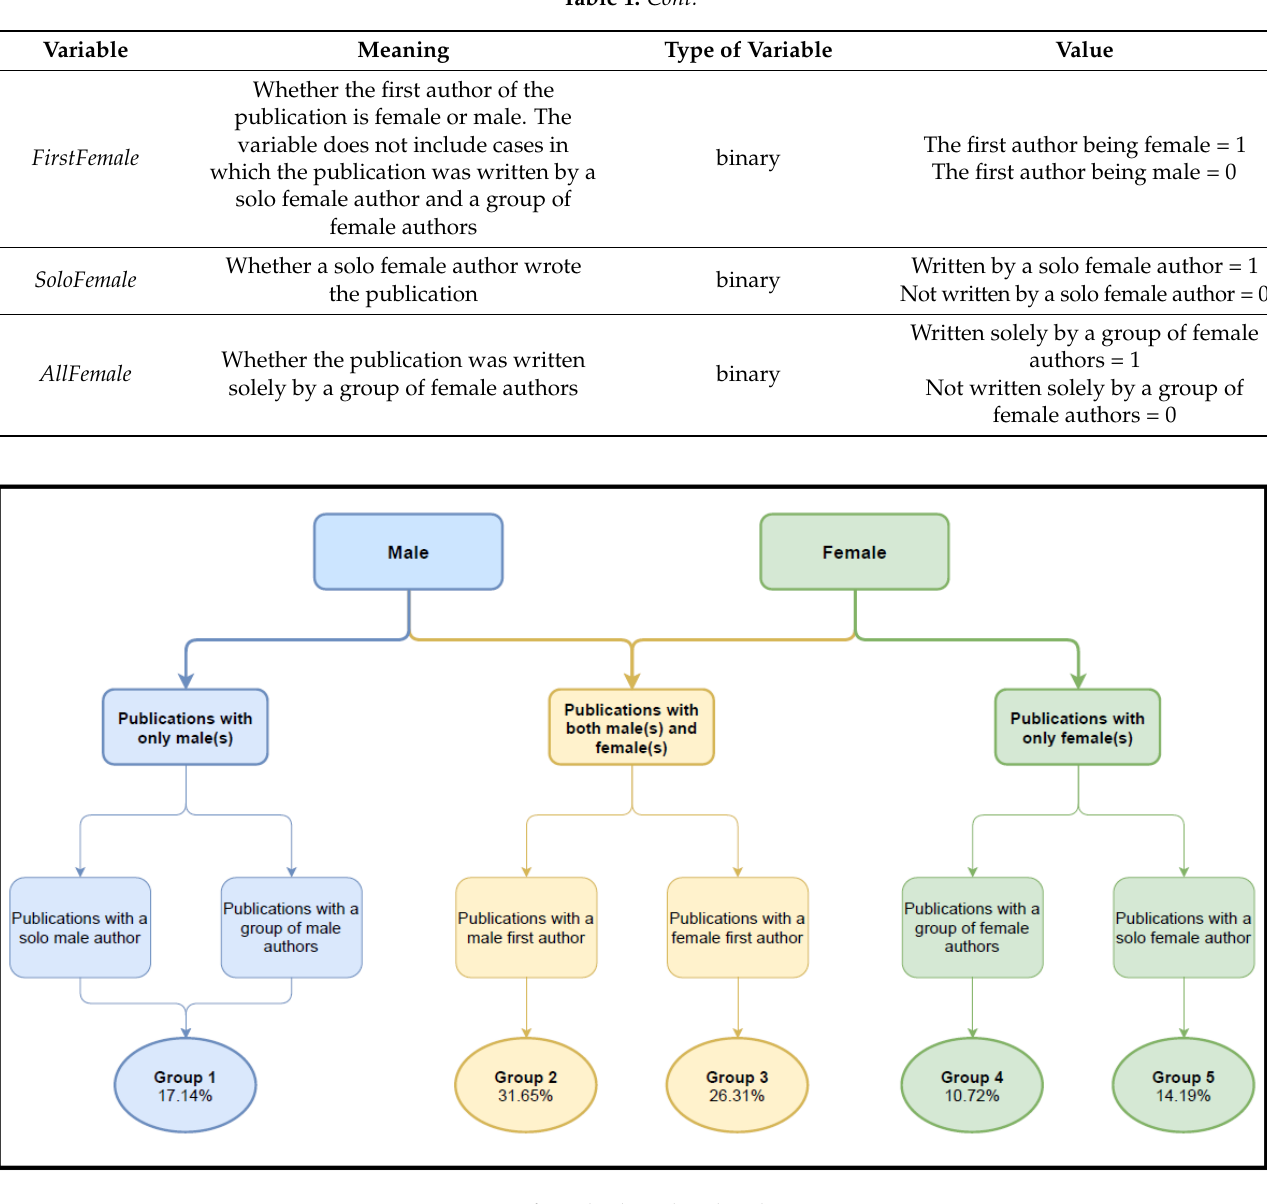
Figure 2. Types of gender-based authorship structures.